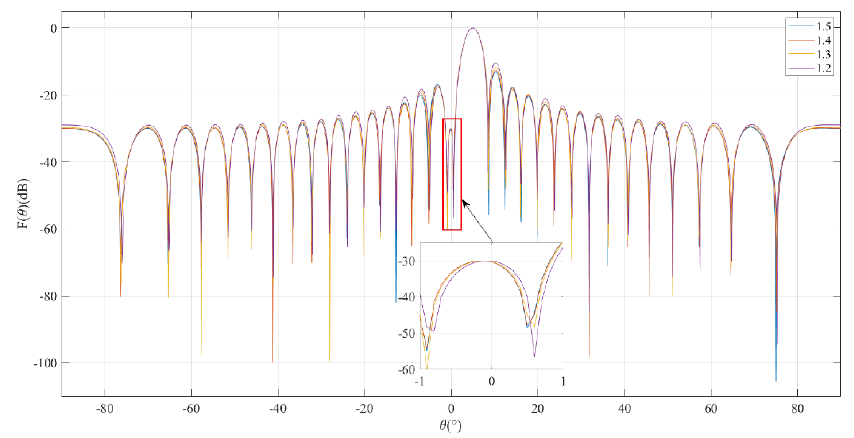
Figure 5. Beam patterns with different δ